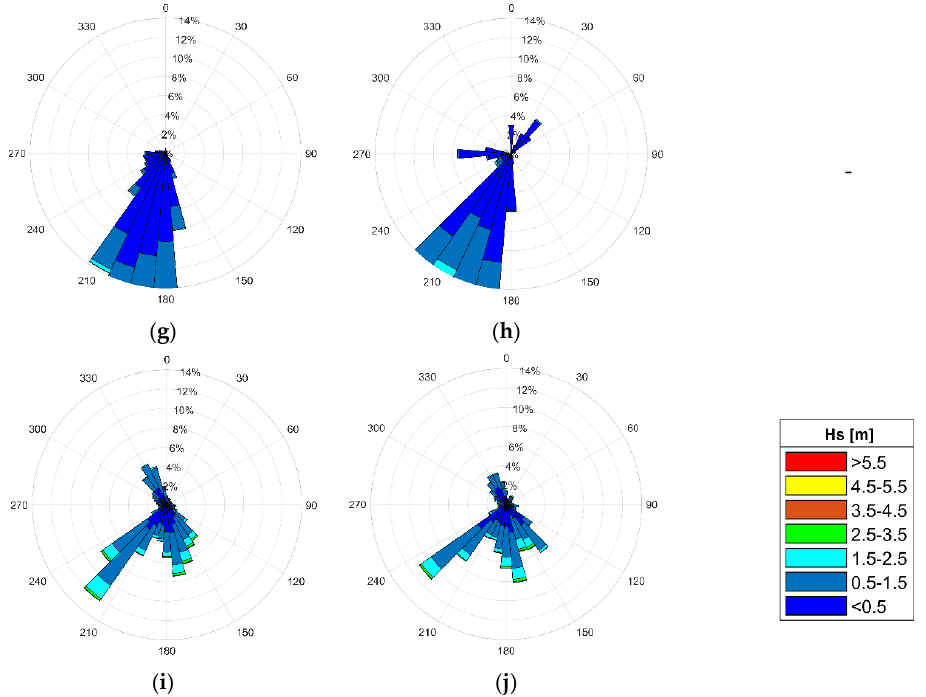
Figure 13. Wave roses of Hs and Dirm for: ( a ) Bastia (no. 3) buoy; ( b ) Bastia wave hindcast point; ( c ) Bastia ERA5 point; ( d ) Capo Mele (no. 5) buoy; ( e ) Capo Mele wave hindcast point; ( f ) Capo Mele ERA5 point. Wave roses of Hs and Dirp for: ( g ) Castiglione (no. 6) buoy; ( h ) Castiglione wave hindcast point; ( i ) Giannutri (no. 8) buoy; ( j ) Giannutri wave hindcast point.